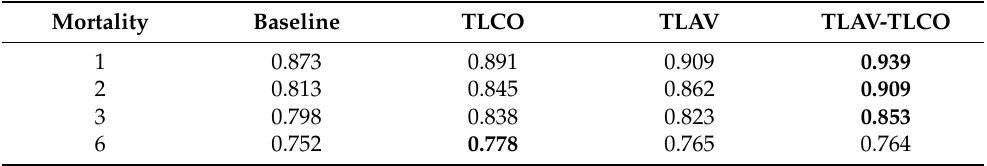
Table 4. Final comparison of the proposed TL framework. TLAV-TLCO is the cascade version of the TL proposed methods. In bold the most relevant results for each mortality